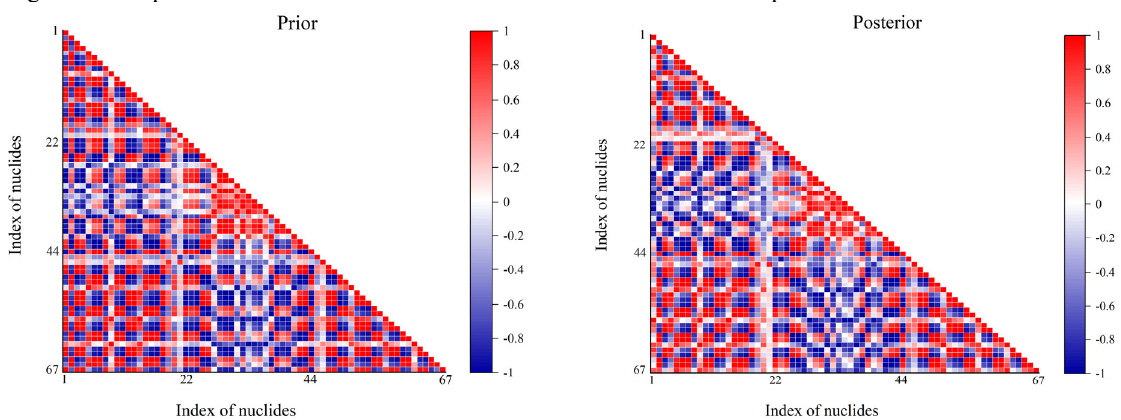
Fig.10. Comparison of prior and posterior fission yields correlation matrices.